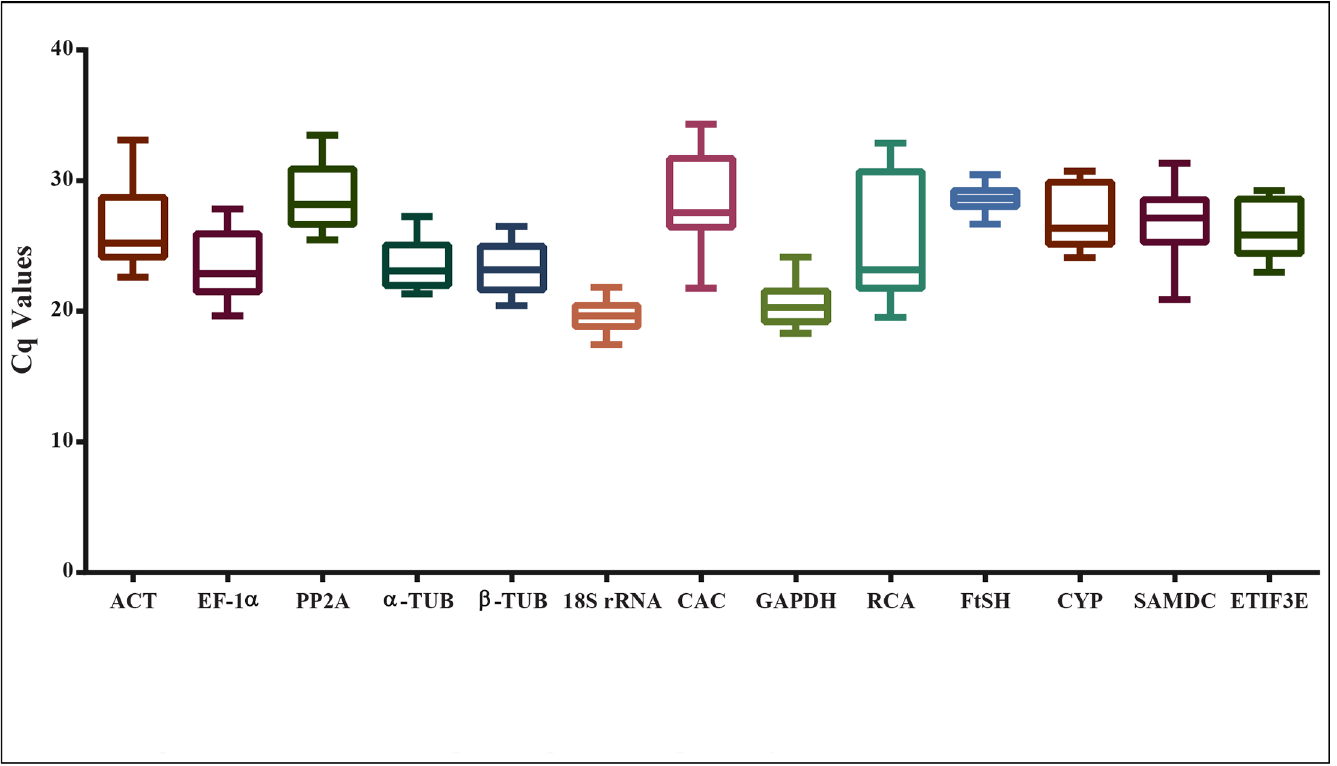
Fig 2. Distribution of quantification cycle (Cq) values across all experimental sets in S . hispanica . The line across the box-plotdepicts the median. Lower and upper boxes represent25 th and 75 th percentiles. Whiskers represent the lowest and highestCq values respectively.